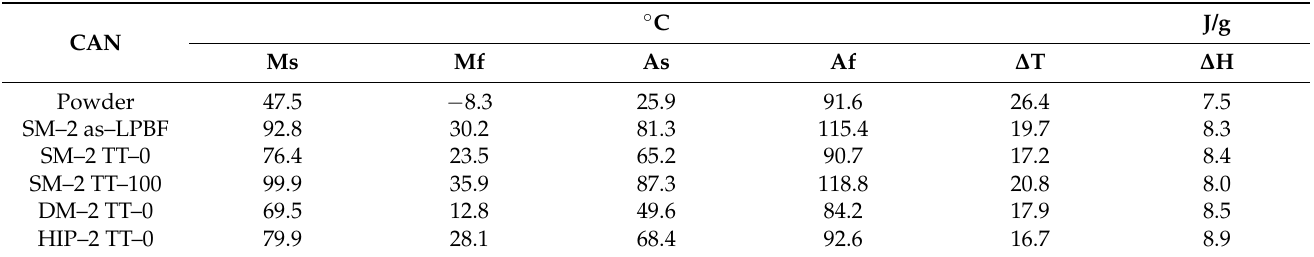
Table 3. Martensitic transformation temperatures, thermal hysteresis, and transformation enthalpies (forward and reverse) for all the processing samples described in the present work and depicted in Figure